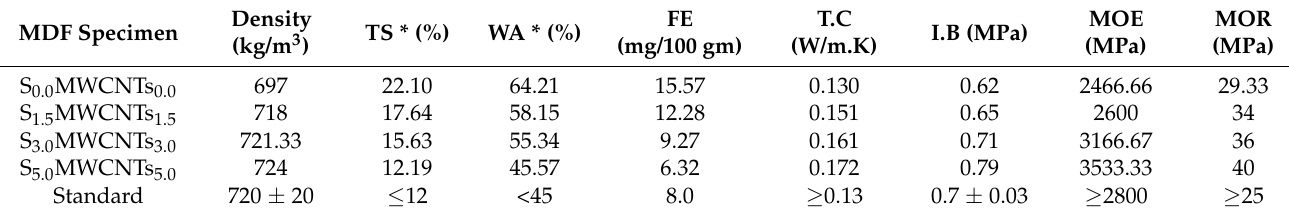
Table 3. The final physical and mechanical properties of 0.016 m MDF samples for diverse absorptions of MWCNTs. MDF